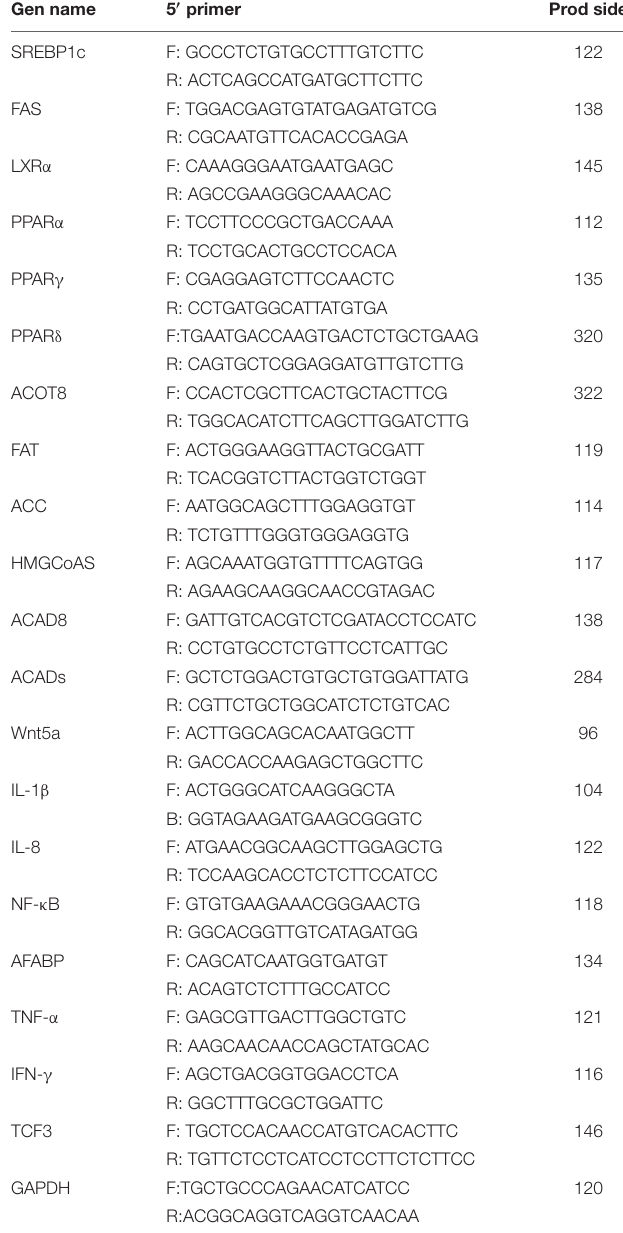
TABLE 2 | Primers used for quantitative real-time PCR